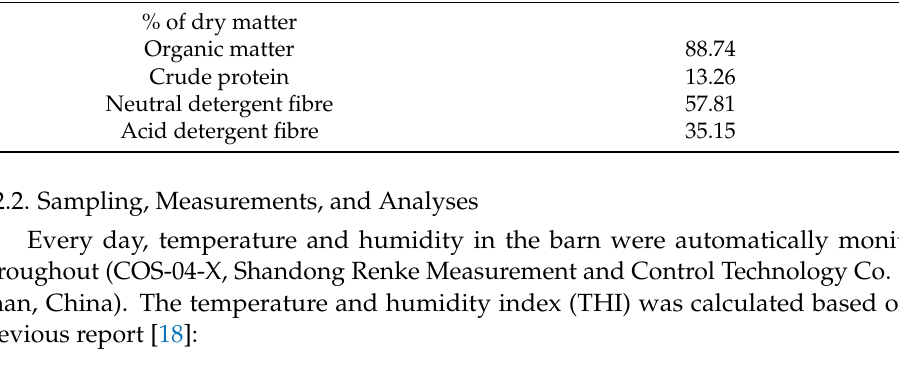
Table 1. Chemical composition of the experimental diets in vivo. Chemical Composition Content (%) % of dry matter Organic matter 88.74 Crude protein 13.26 Neutral detergent fibre 57.81 Acid detergent fibre